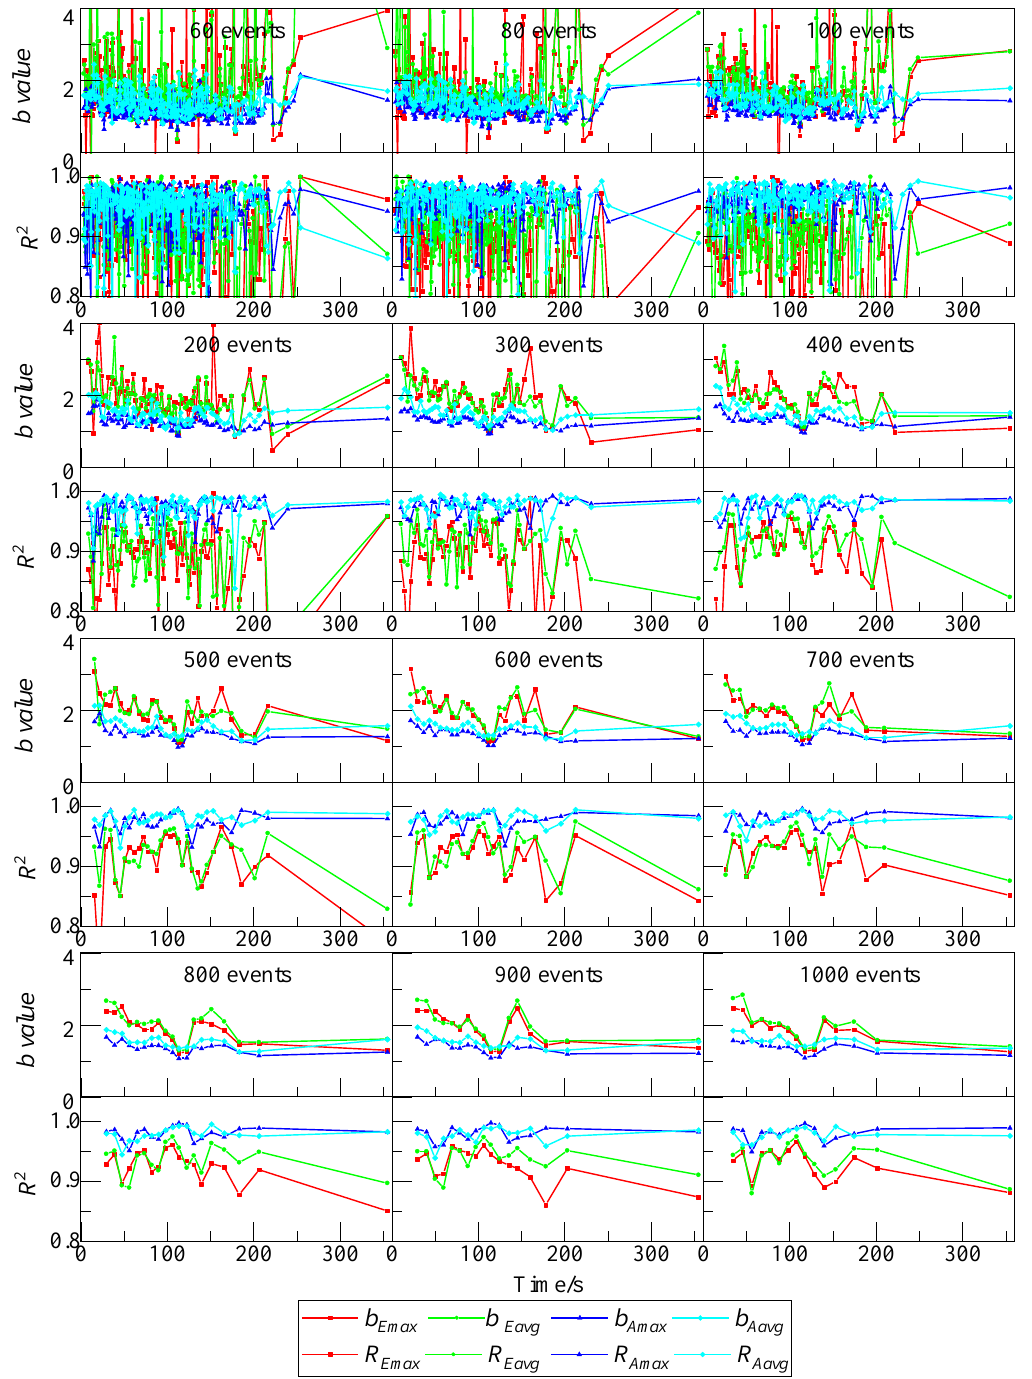
Figure 6. b value and its fitting goodness at different AE event count intervals for specimen G-10-10. The range of b Amax values is between 0.63 to 2.17.